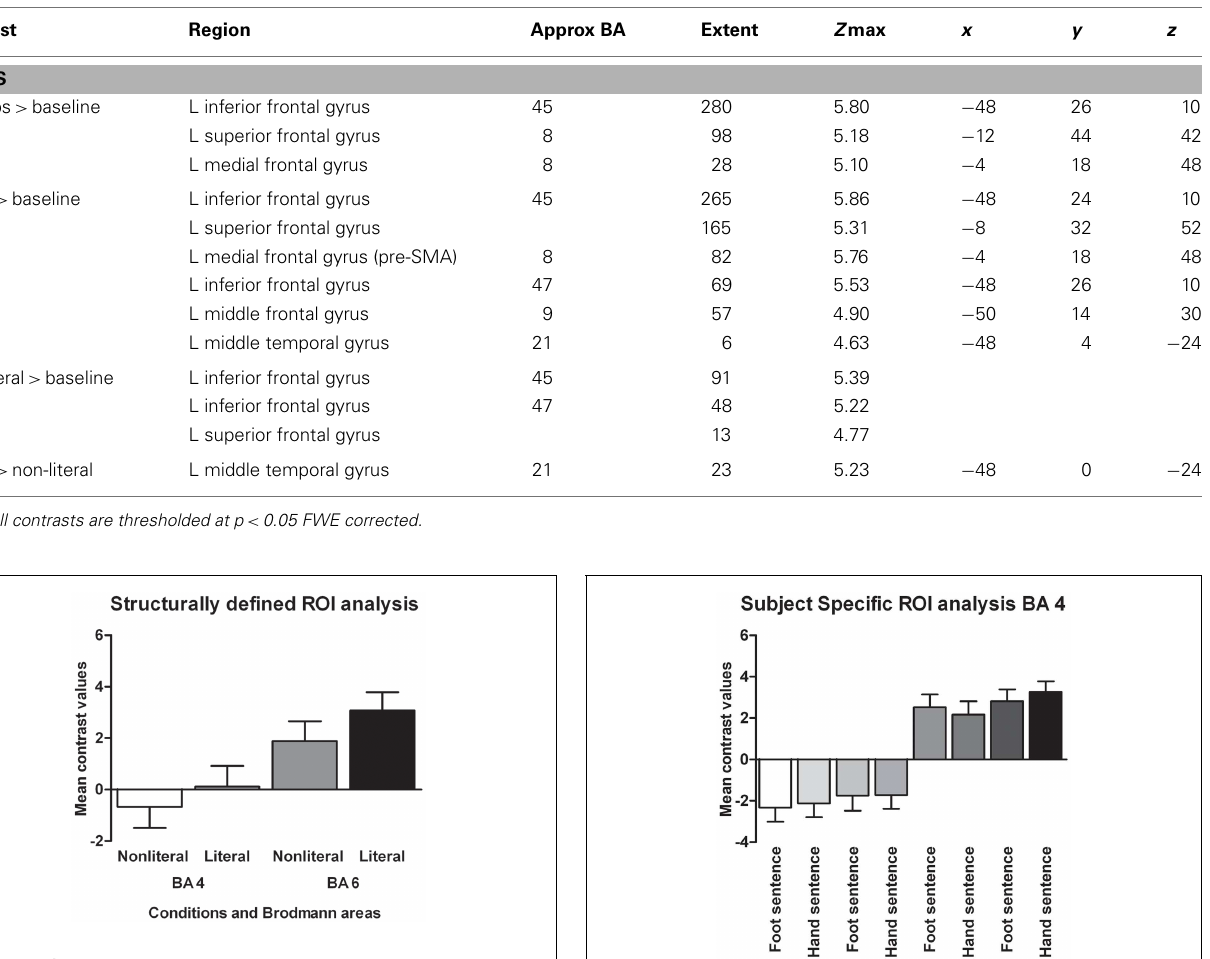
FIGUREA2 |Additional structurally defined ROI analysis. The mean contrast values compared to an implicit baseline are shown for each Brodmann area and sentence type.